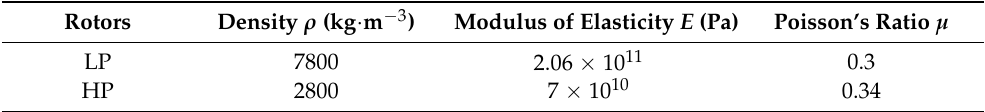
Table 4. Material parameters of the